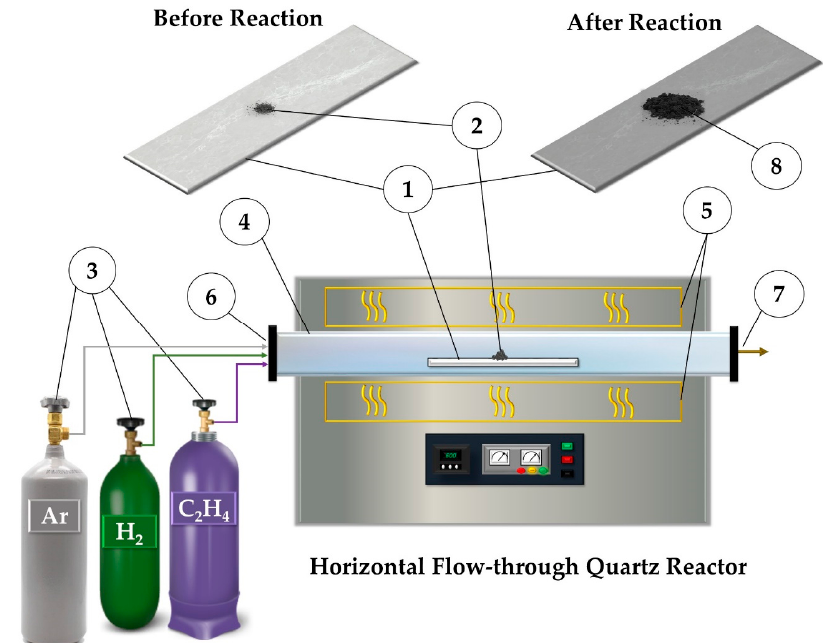
Figure 10. Scheme of the experimental setup used for the synthesis of Pt 1 − x Ni x /CNF composites: 1—quartz plate; 2—sample of Pt 1 − x Ni x alloy; 3—gas vessels; 4—tubular quartz reactor; 5—heating elements; 6—input of the reaction mixture (C 2 H 4 /H 2 /Ar); 7—output of reaction gases; 8—resulting Pt 1-x Ni x /CNF